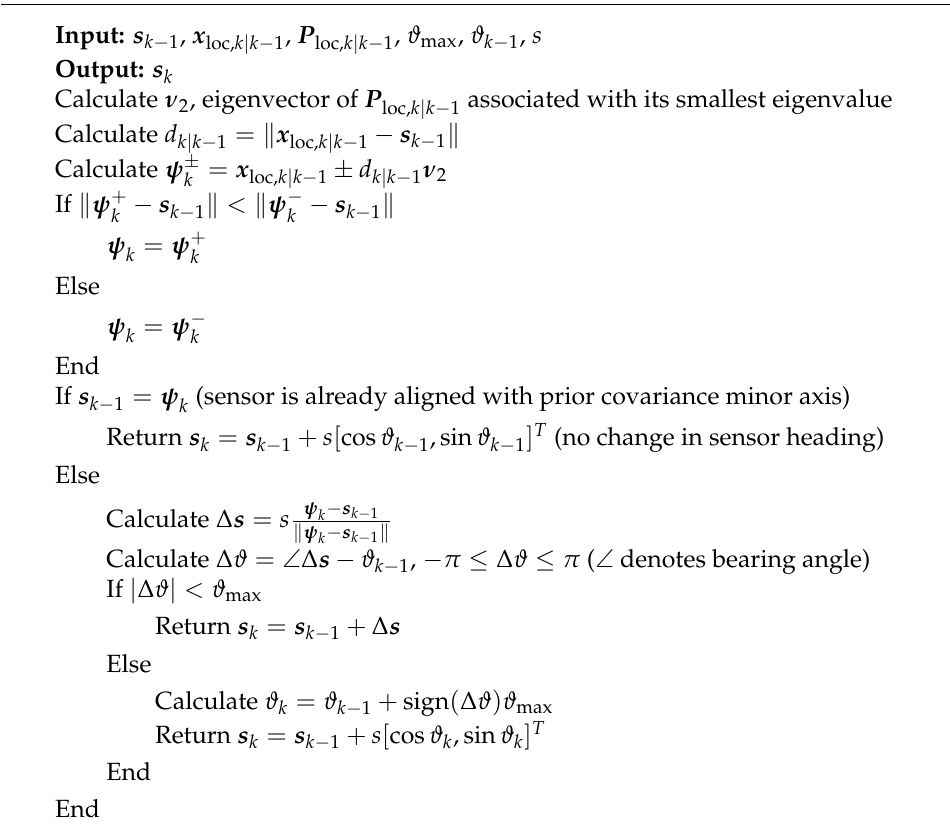
Algorithm 1 Projection